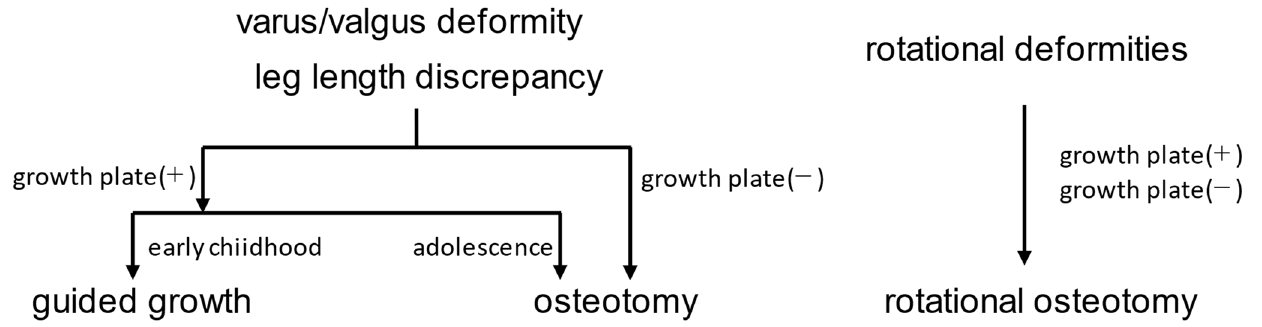
Figure 4. Brief algorithm of the surgical indication and method for varus or valgus deformities and leg length discrepancies, which are corrected by the guided growth method in early childhood and by osteotomy in adolescence. Rotational deformities are corrected by osteotomy in all patients.